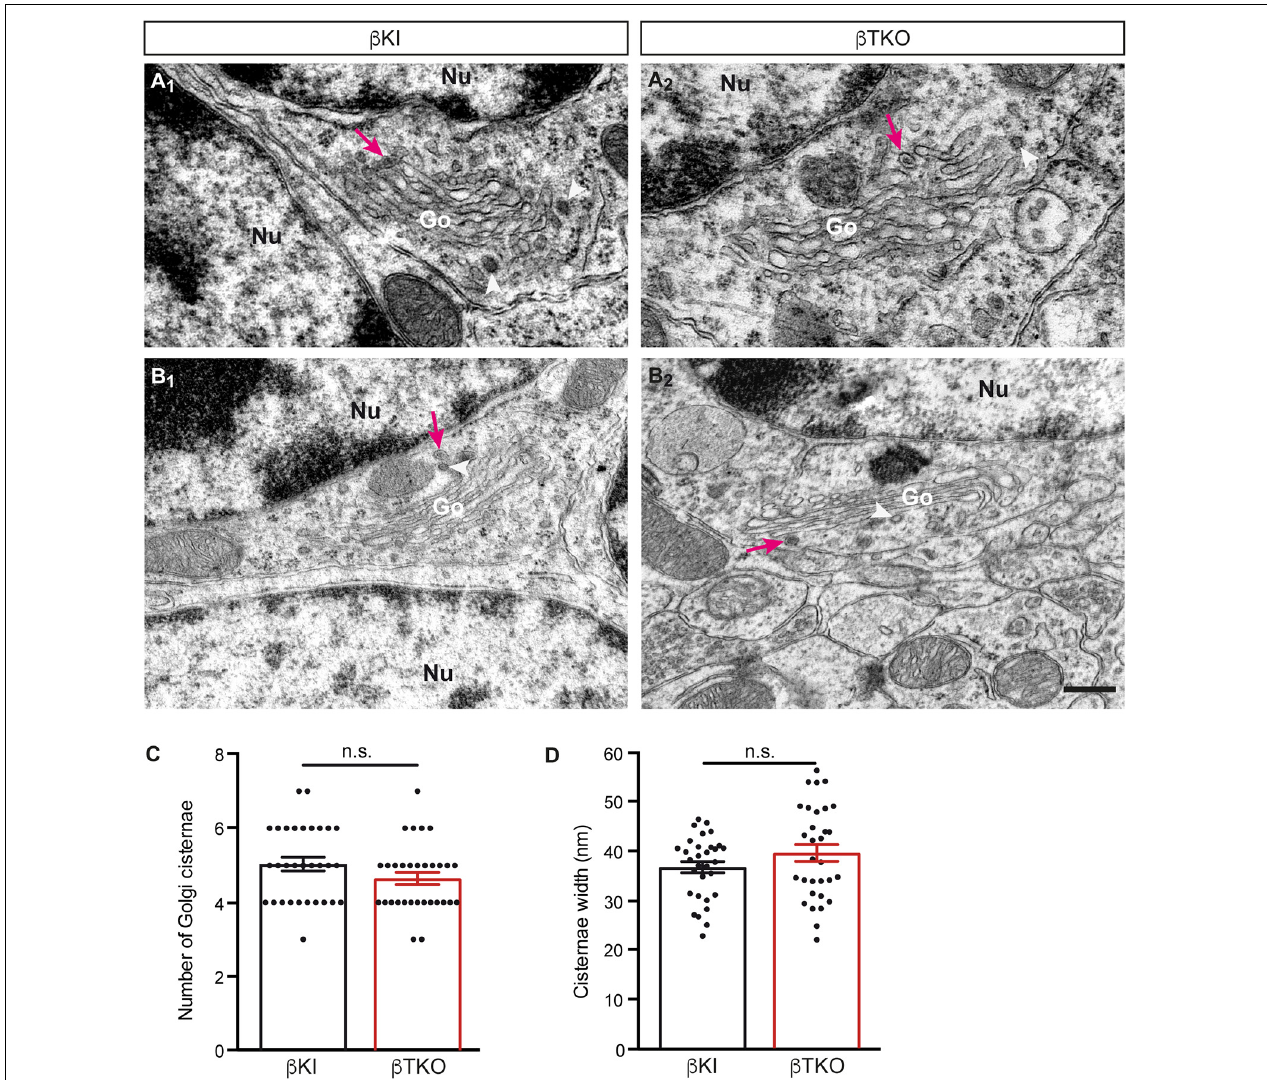
FIGURE 7 | Normal Golgi morphology in CGCs of β -Nrxn-deficient mice. (A 1 ,A 2 ) Representative electron microscopic images of the Golgi apparatus (Go) of CGCs from β -KI control mice. Note visible DCVs (magenta arrows) in the vicinity of Golgi stacks. Nu, nucleus; arrowheads, coated vesicles. (B 1 ,B 2 ) Similar images as in panels (A 1 ,A 2 ) but from β -Nrxn-deficient β -TKO cerebellum. Labels as in panels (A 1 ,A 2 ) . Scale bar for all images: 250 nm. (C,D) Histograms showing the number of cisternae (C) and the width of cisternae (D) on random cross-sections of the GCL from β -KI control (black bars) and β -Nrxn-deficient β -TKO (red bars) cerebella. Data are shown as mean ± SEM, dots indicate individual data points. Measurements are based on n = 31 Golgi apparatus from three mice per genotype; significance difference indicated as n.s. = non-significant, two-tailed unpaired t